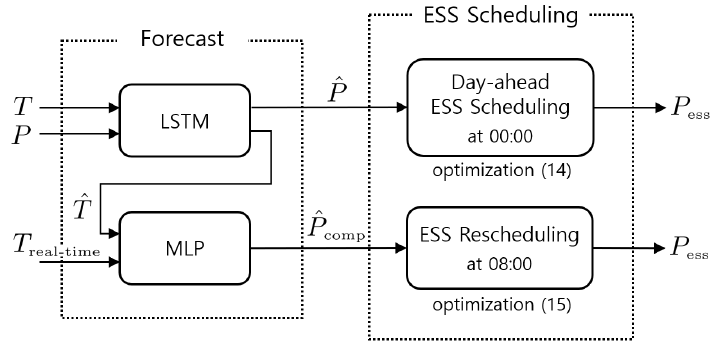
Figure 1. The proposed Energy Storage System (ESS) scheduling using load